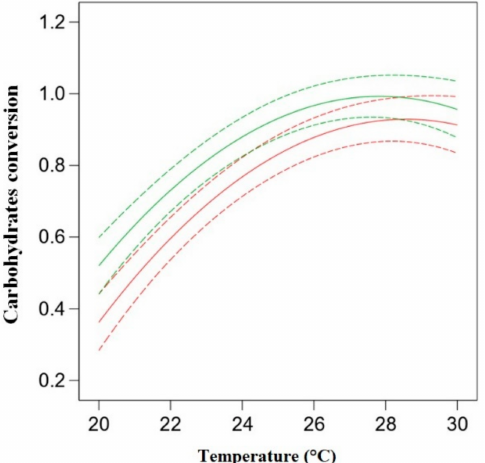
Figure 4. Effect of the fermentation temperature and pretreatment condition on the acetic acid conversion (green = acid hydrolysis, red = hydrothermal), fermentation conditions: pH = 5.5, 100 rpm, t = 24 h. Straight lines represent average value. Dashed lines represent lower and upper level with 95% confidence